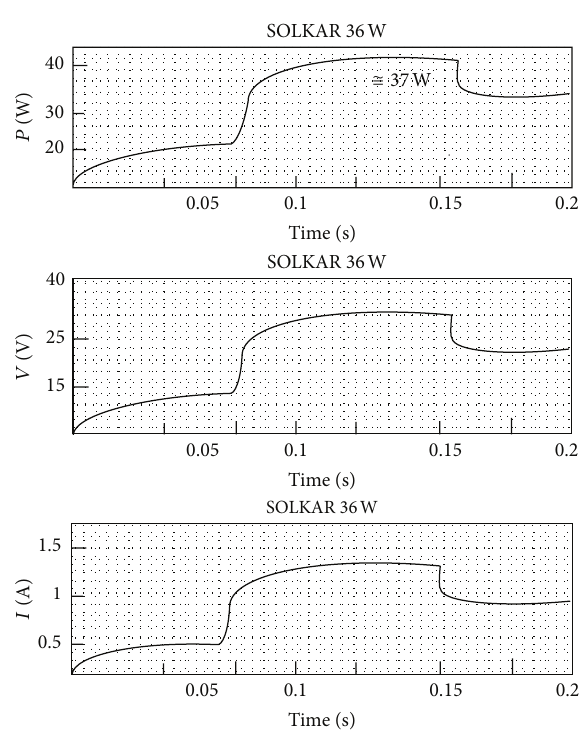
Figure 21: Power, voltage, and current tracking of SOLKAR 36 W.